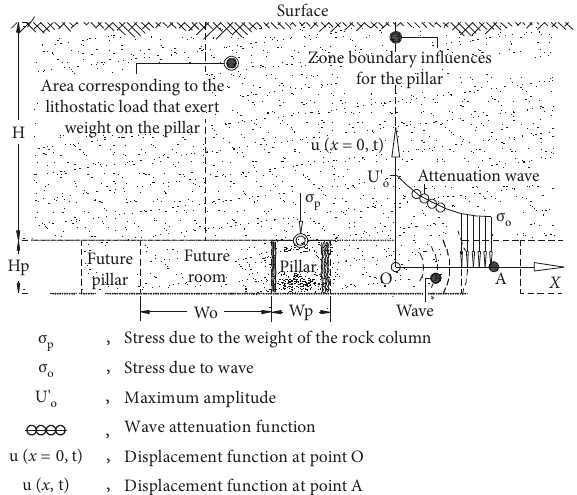
Figure 1: Wave stress in the mineral extraction process with explosives in the room and pillars